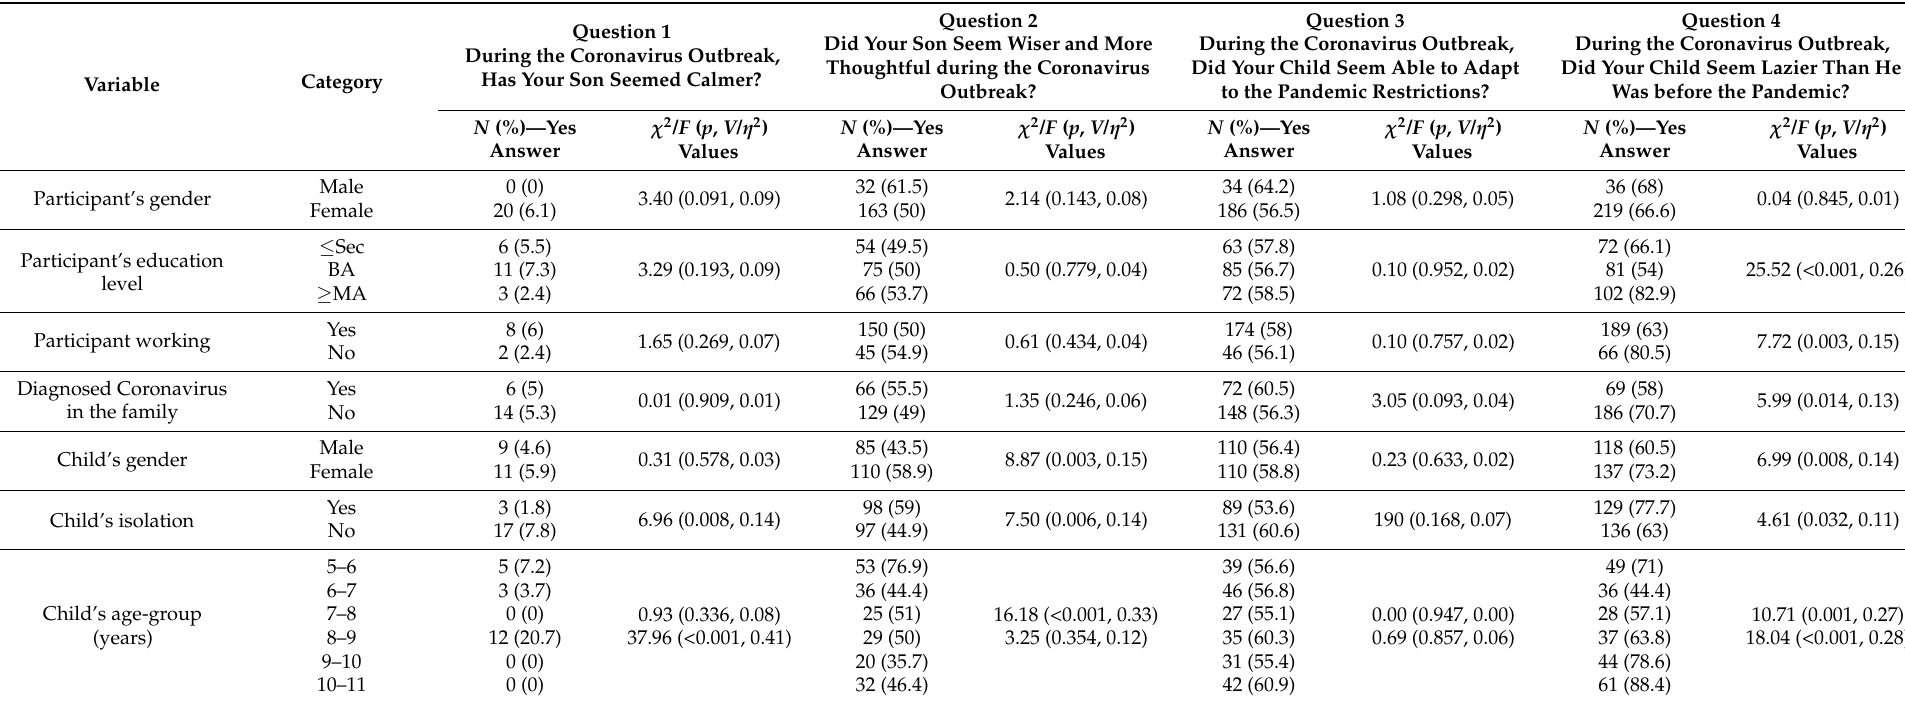
Table 5. Participants’ answers to the adaptation behavior area questions by the study